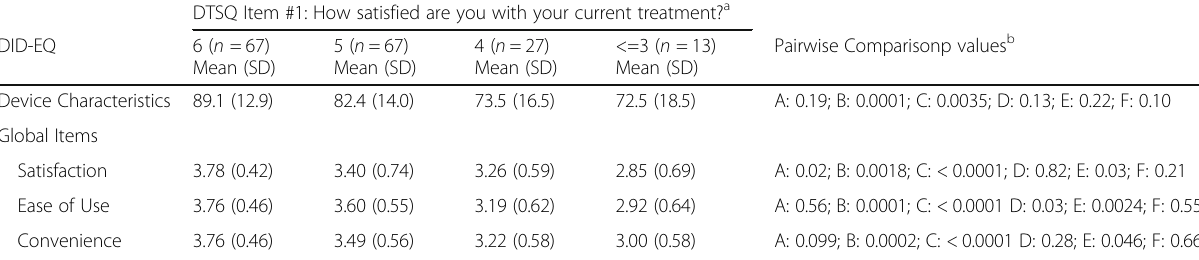
a Higher DTSQ scores indicate greater satisfaction b ANOVA with Scheffe ’ s post-hoc comparisons of DID-EQ scores between subgroups of participants categorized based on scores on DTSQ item #1 (A: DTSQ item #1 score of 6 vs. 5; B: 6 vs. 4; C: 6 vs. <=3; D: 5 vs. 4; E: 5 vs. <=3; F: 4 vs.